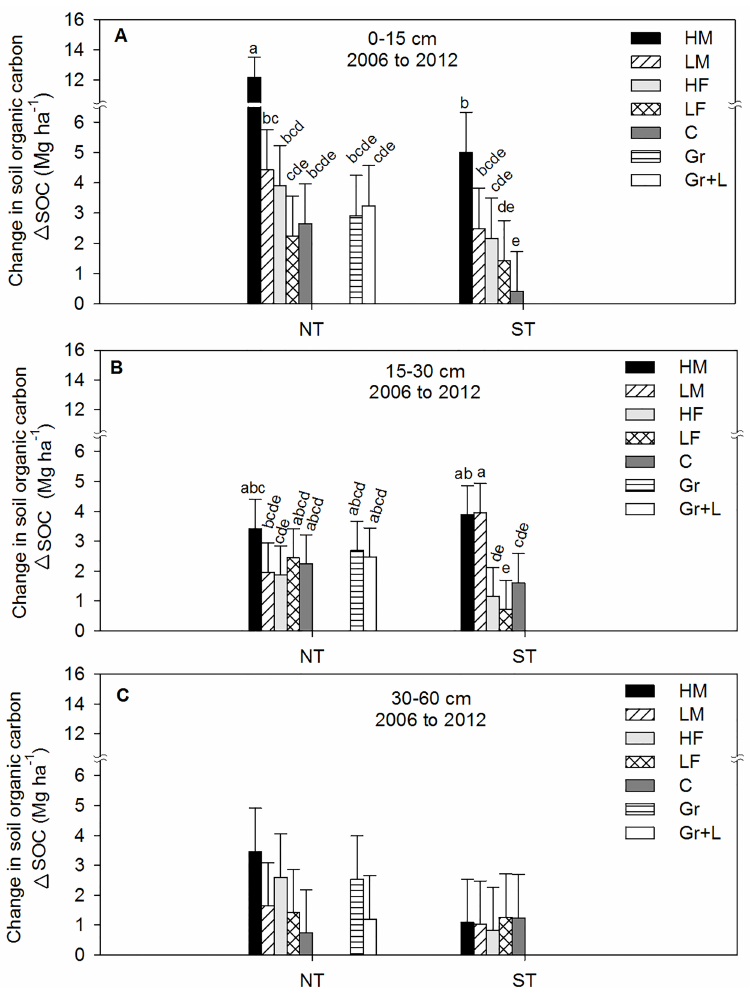
Fig 5. Change in soil organic carbon ( Δ SOC) measuredin Mg ha -1 from 2006 to 2012 as influenced by at different tillage treatments, soil depth, nitrogen (N) treatments, and grasses. NT represent no-tillage; ST represent shallowtillage; HM treatment represents beef manure additionat three times the recommended N (high) rate; LM treatment representsbeef manure addition at the recommended (low) rate; HF treatment represents inorganicfertilizer (urea) additionat doublethe recommended N (high) rate; LF treatment represents inorganicfertilizer (urea) additionat the recommended (low) rate; C treatment represents no nitrogenaddition(control); Gr represents the native grass; and Gr +L represents the mixture of native grass and legume.(A) represents 0–15 cm; (B) represents15–30 cm; and (C) represents30–60 cm. The error bars representstandard errors of the mean. The different lowercaseletters represent significantdifferencesamong N treatments (P < 0.05).